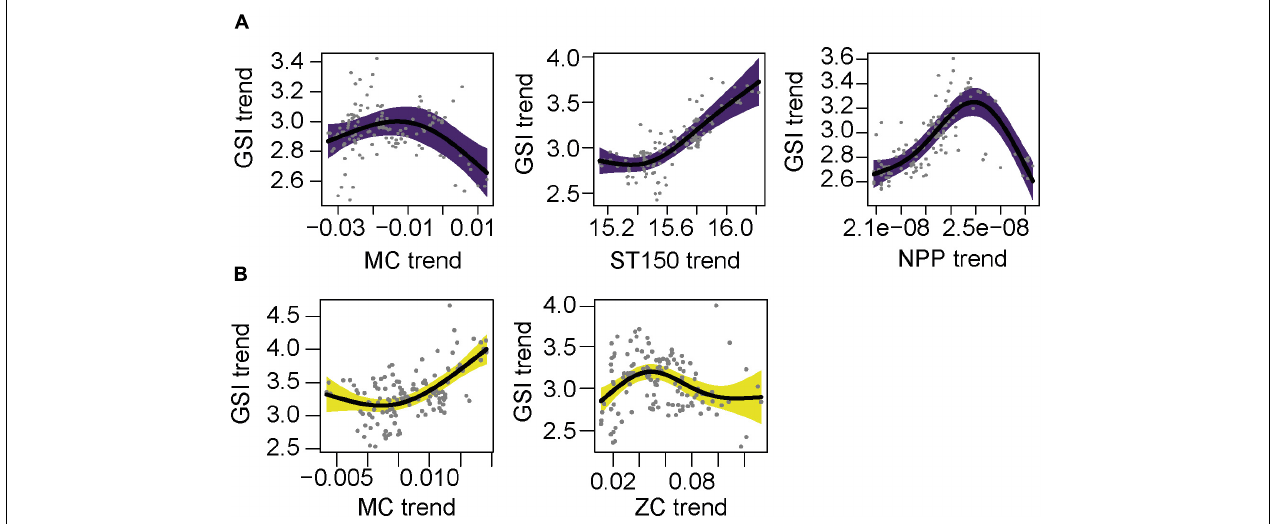
FIGURE 6 | Partial GAM plots for gonadosomatic index (GSI) of anchovy female ( Engraulis encrasicolus ) for each area; (A) North (purple) and (B) South (yellow). Significant partial effects of meridional current (MC), zonal currents (ZC), average sea temperature of 150 m (ST-150) and net primary production (NPP) are represented. The shaded areas indicate the 95% confidence